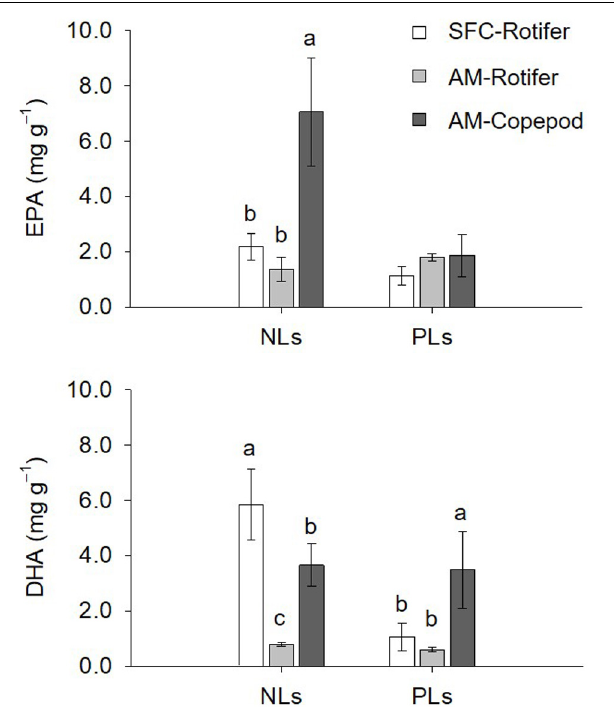
FIGURE 3 | Dry mass-based contents of eicosapentaenoic acid (EPA) and docosahexaenoic acid (DHA) for non-polar lipids (NLs) and polar lipids (PLs) in enriched preys. SFC-Rotifer represents rotifers fed docosahexaenoic acid-supplemented Super Freshwater Chlorella (SFC). AM-Rotifer and AM-Copepod represent rotifers and copepods fed algal mixture, respectively. Values represent means ± standard deviation ( n = 3). Letters above bars indicate significant differences (Tukey test, p < 0.05, a > b >